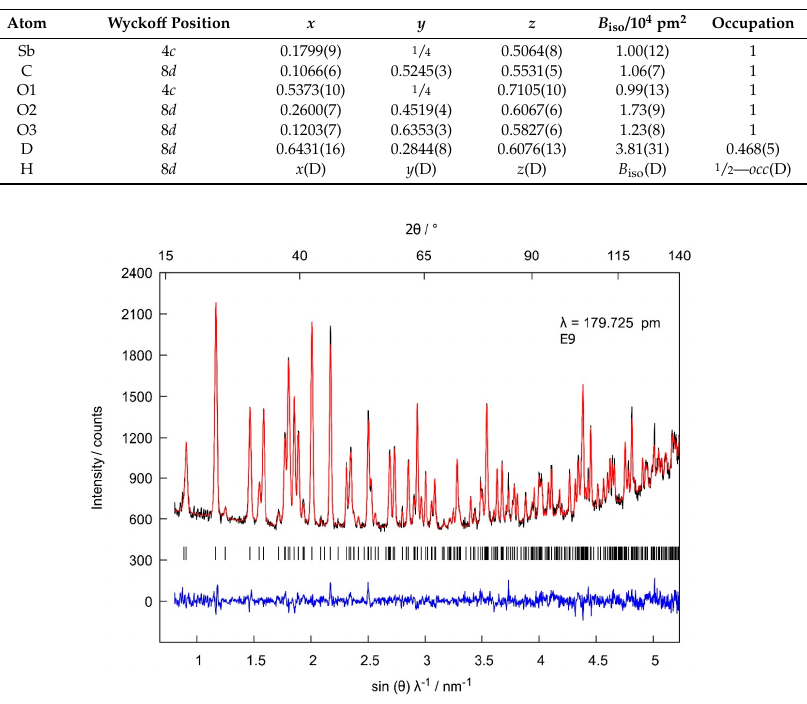
Figure 2. Rietveld refinement of the crystal structure of SbC 2 O 4 OD at T = 298(1) K based on neutron powder diffraction data (black: measured diffraction data, red: calculated diffraction pattern, blue: difference between measured and calculated pattern, black bars: Bragg reflection markers; λ = 179.725 pm).